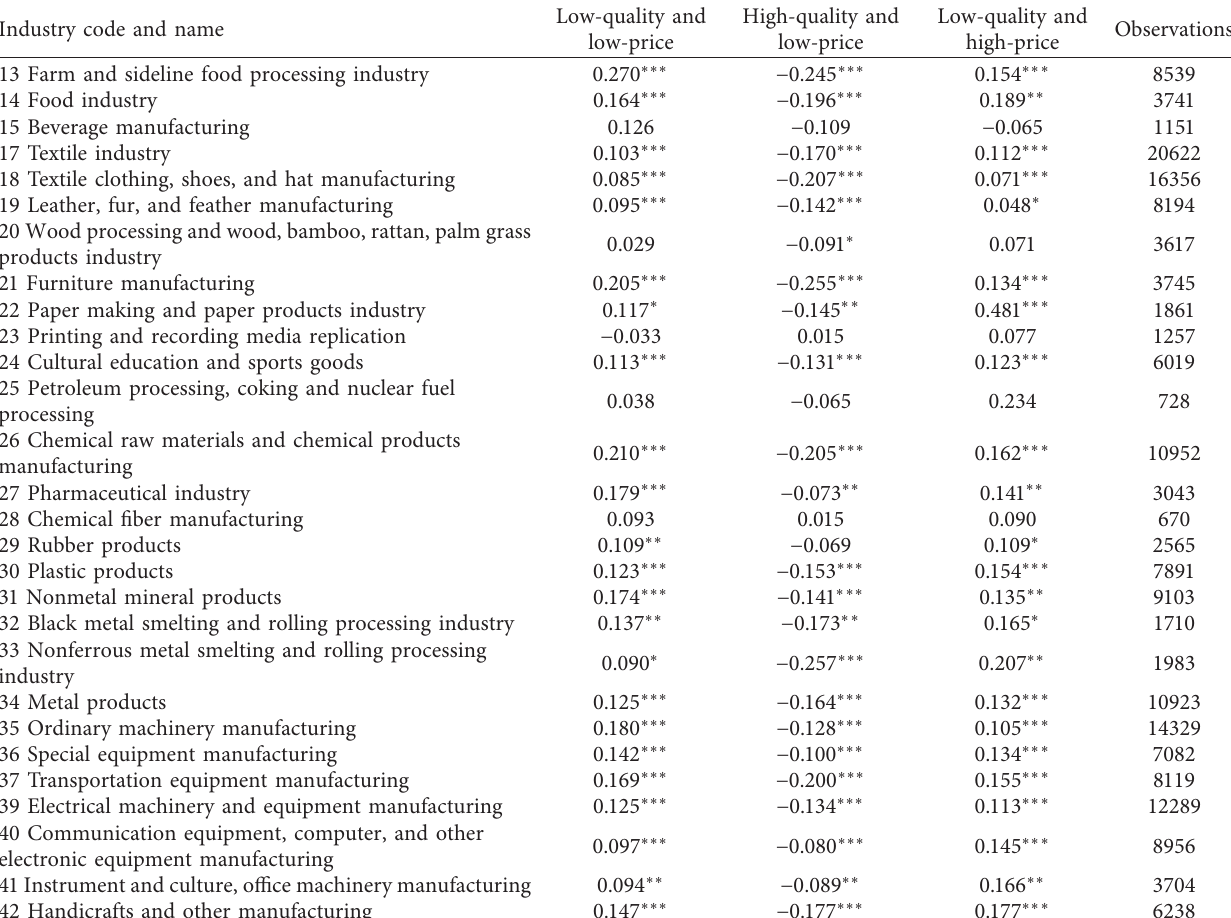
Table 7: The estimated results of regressions on subsamples classified by industries.